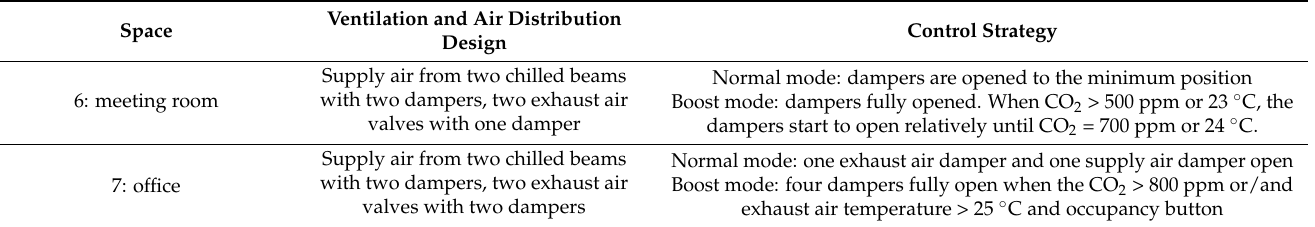
Table 5. Ventilation and air distribution design and control strategies for Type 3 spaces.